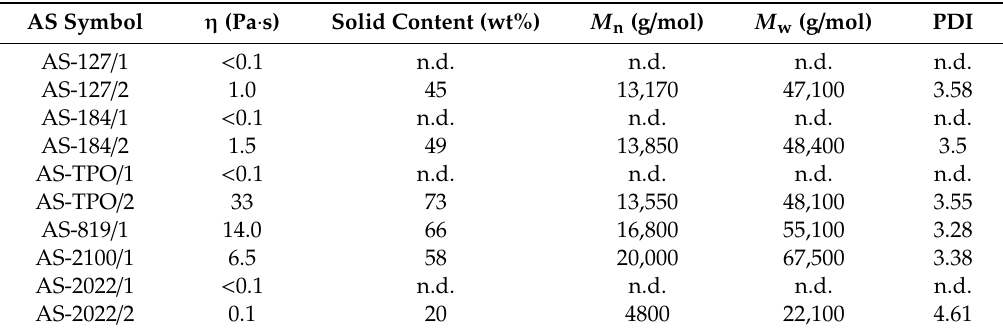
Table 3. Dynamic viscosity, solid content, and molecular weights of